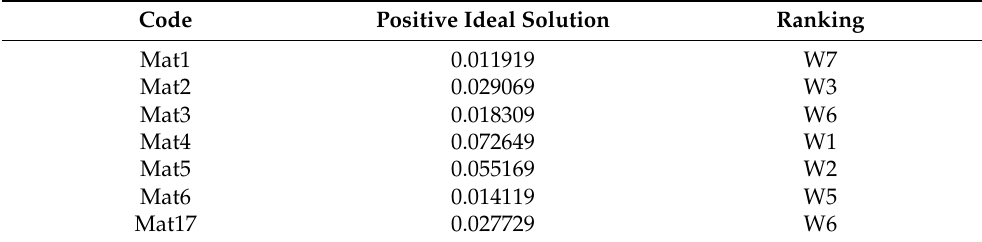
Table 15. TOPSIS ranking.